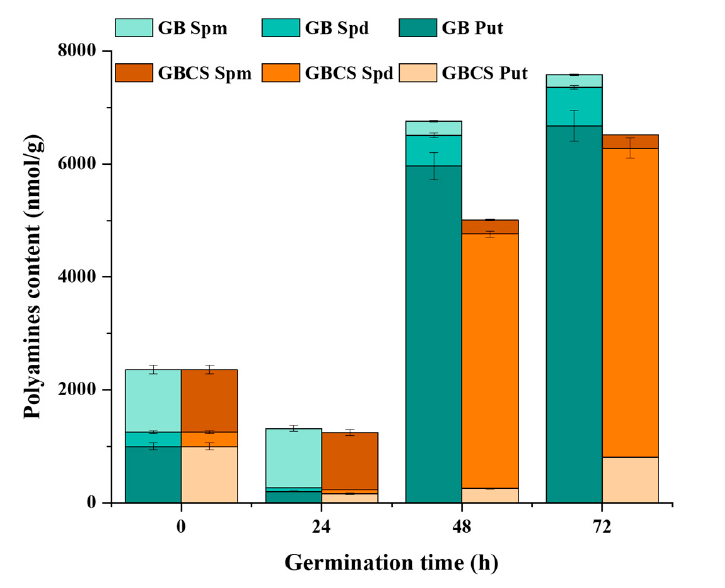
Figure 9. Change in polyamines content influenced by cold stress and germination. GB Spm, Spd, and Put, the content of spermine, spermidine, and putrescine in germinated black rice grain without cold stress, respectively; GBCS Spm, Spd, and Put, the content of spermine, spermidine, and putrescine in germinated black rice grain under cold stress at 0 ◦ C for 1 h, respectively.